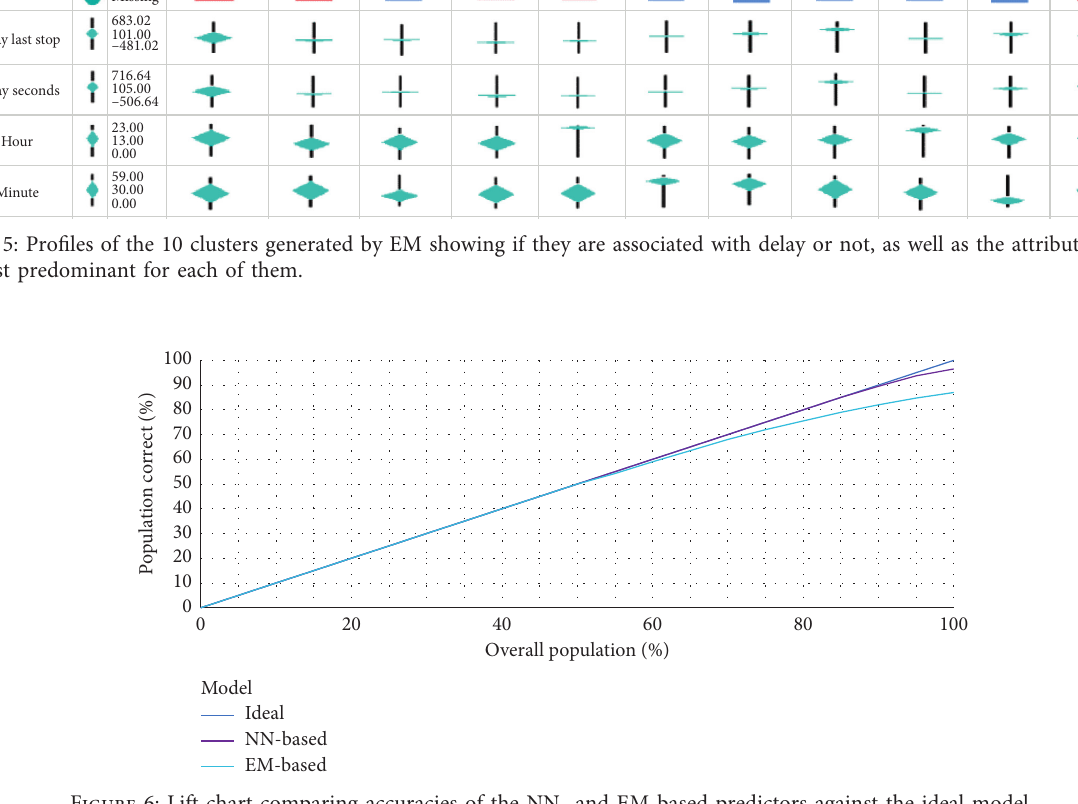
Figure 6: Lift chart comparing accuracies of the NN- and EM-based predictors against the ideal